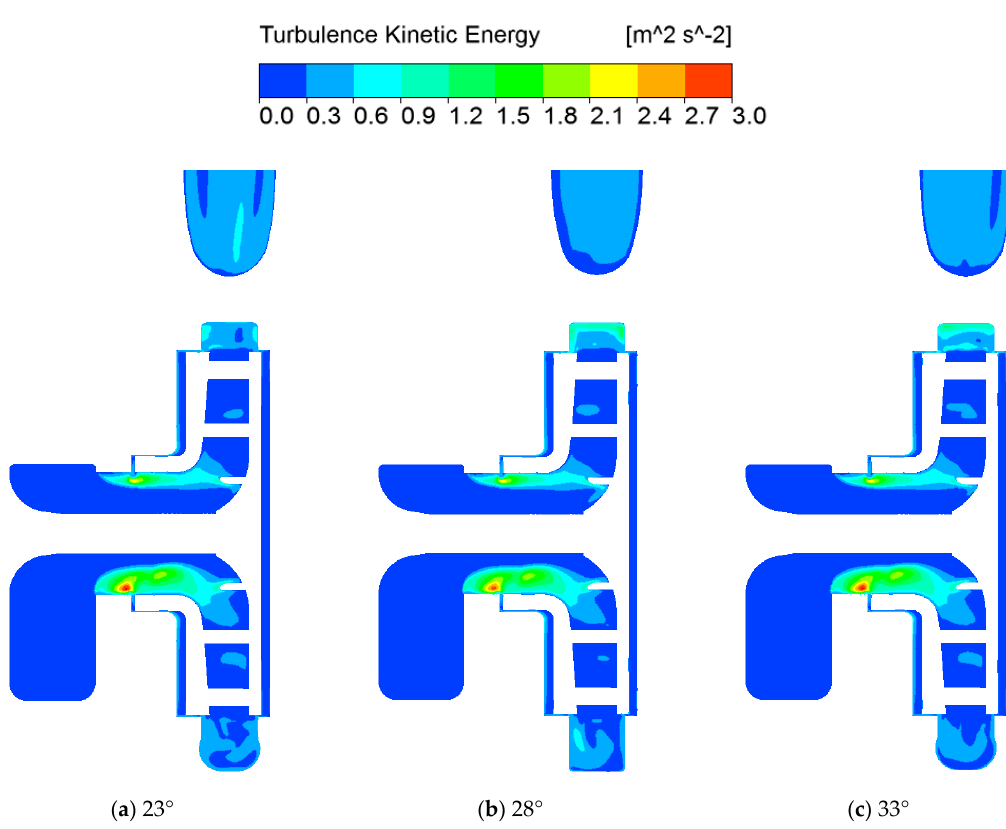
Figure 18. Distribution of turbulent kinetic energy under design condition with different tongue angles.